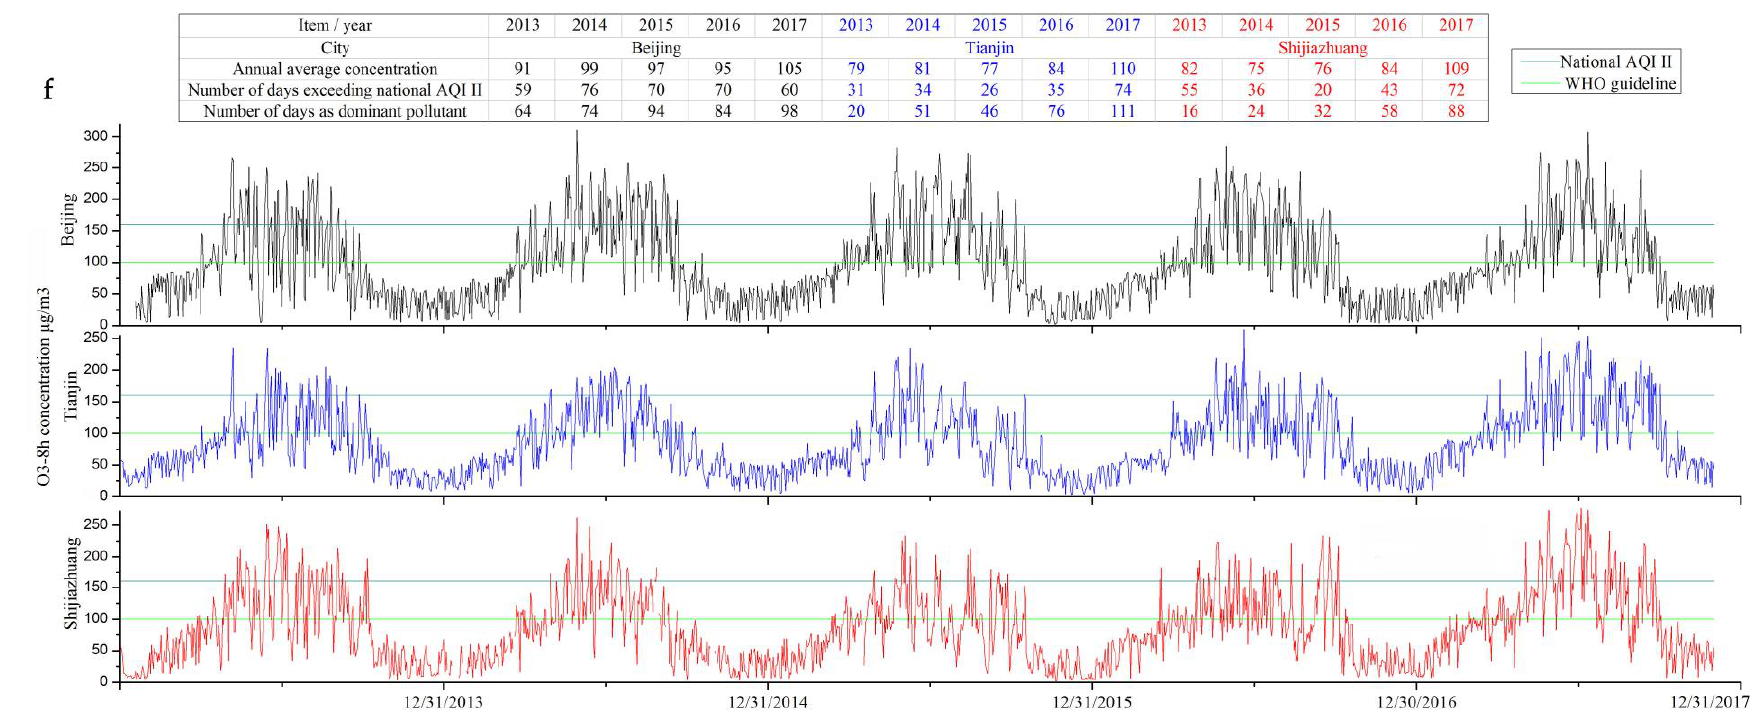
Figure 1. Trends of the daily AQI ( a ), PM 10 ( b ), PM 2.5 ( c ), NO 2 ( d ), SO 2 ( e ) and 8 h-O 3 (daily maximum 8 h concentration) ( f ) concentrations in Beijing, Tianjin and Shijiazhuang. According to the Ambient air quality standards (GB3095-2012) and Technical Regulation on Ambient Air Quality Index (HJ 633-2012), below the limit value II, the air quality is good (II) or very good (I); above the limit value II, the air quality is slightly polluted (III), moderately polluted (IV), heavy polluted (V), and sever polluted (VI).